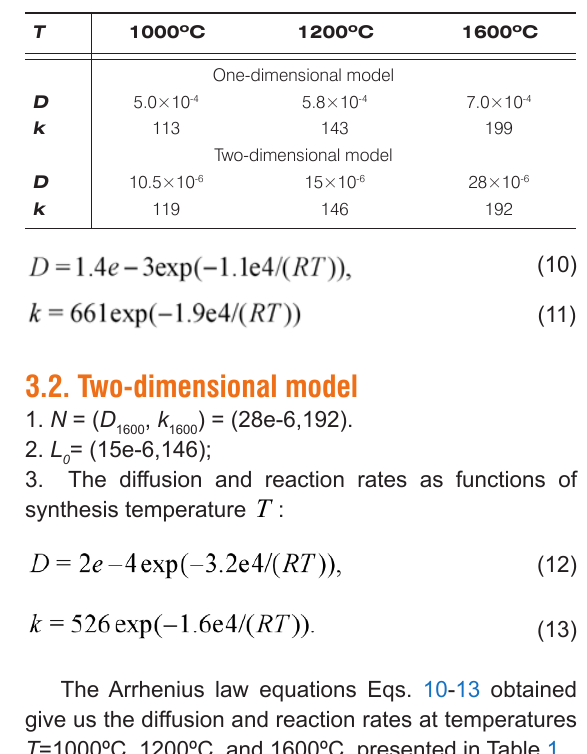
Table 1. Diffusion and reaction rates.